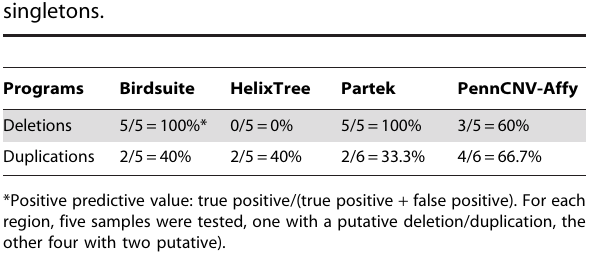
and variance of hybridization intensity over the region included